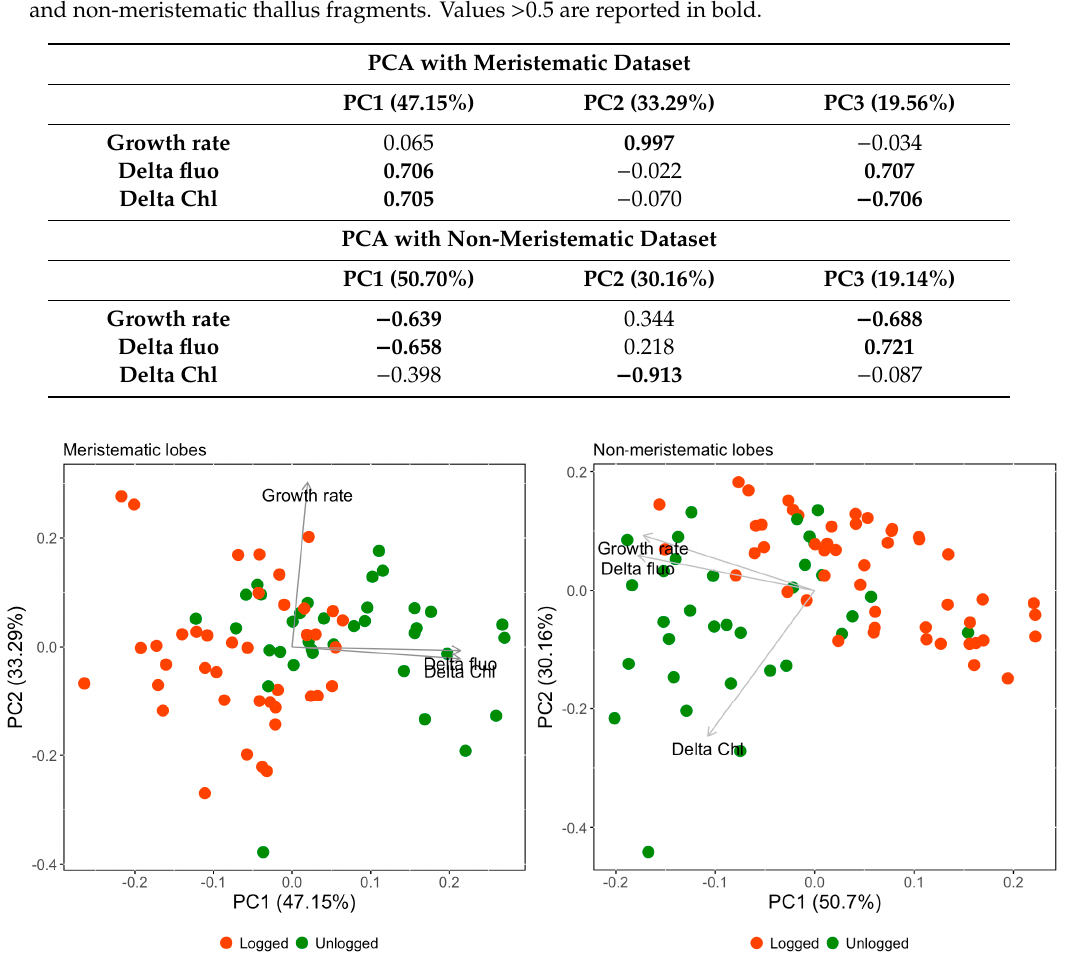
Table 1. Matrix of variable loadings reporting the eigenvalues of the three principal components of the PCA ordinations (explained variance in brackets), which were performed separately for meristematic and non-meristematic thallus fragments. Values >0.5 are reported in bold.